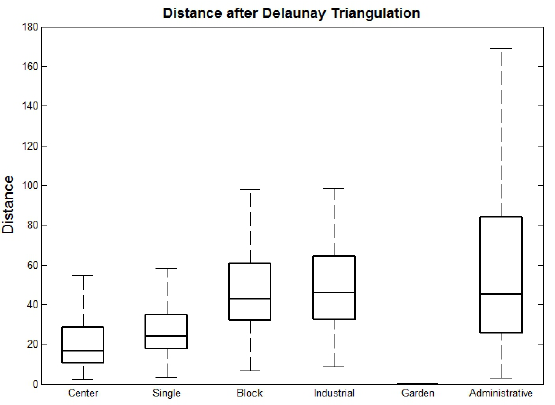
Figure 3: Edge distances after Delaunay Triangulation